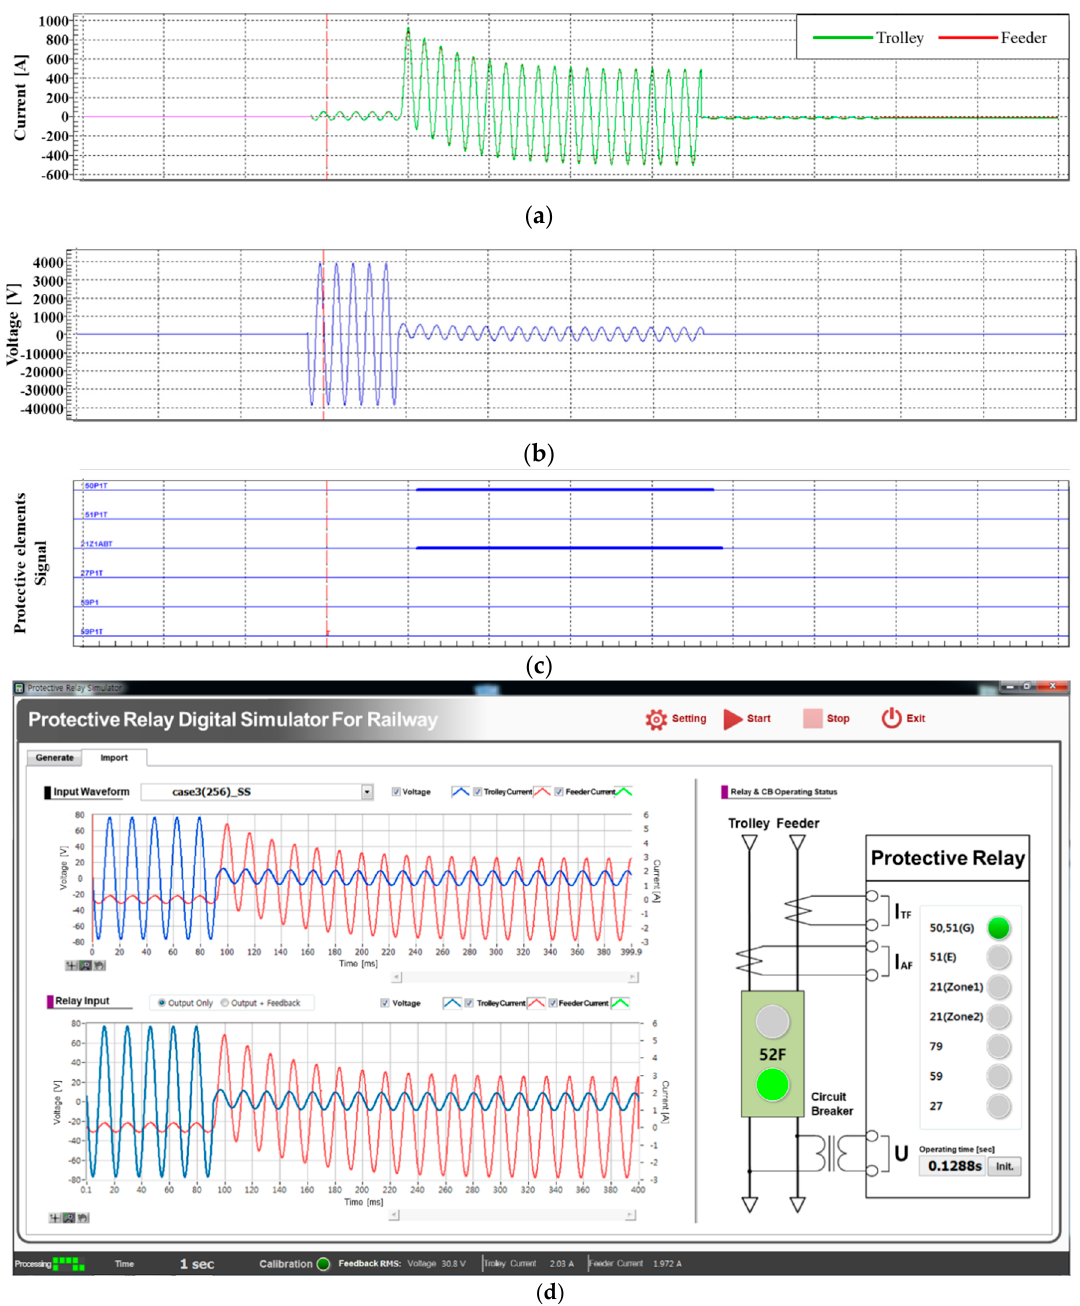
Figure 17. Simulation results for Case 3: ( a ) Input current; ( b ) Input voltage; ( c ) Protective relay signal; and ( d ) Digital simulator interface results.